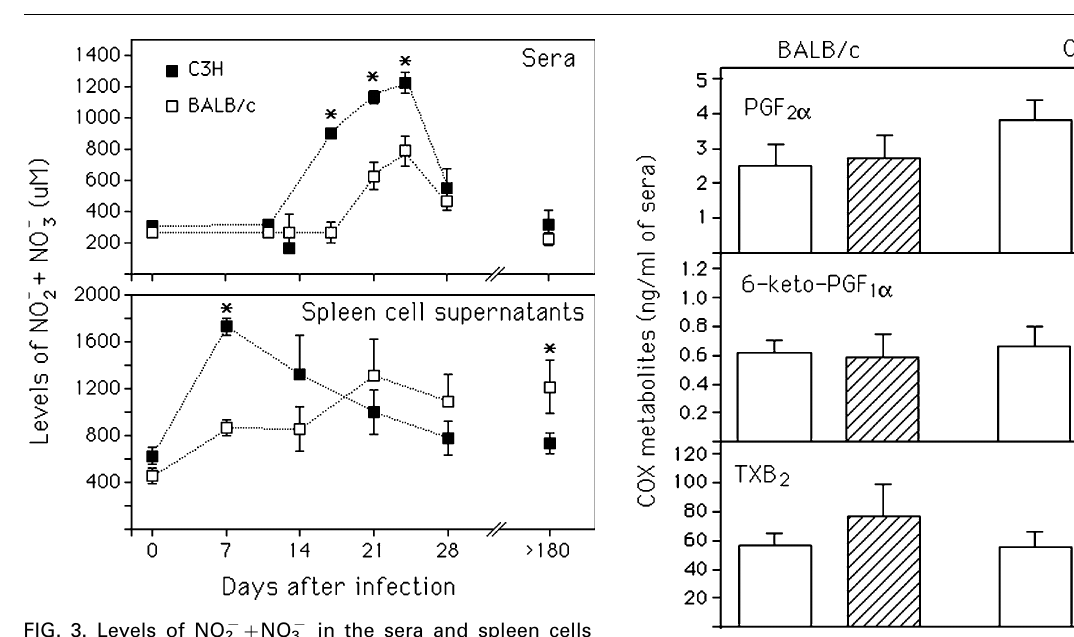
FIG. 3. Levels of NO 2 (cid:3) (cid:2) / NO 3 (cid:3) in the sera and spleen cells supernatants of acutely and chronically ( (cid:3) / 180 days p.i.) infected C3H and BALB/c mice. Means 9 / standard errors of 4 (cid:1) / 6 mice/group are shown. In the cell supernatants, the values increased over the non-infected control at 7 days p.i. in C3H mice and at 21 days p.i. in BALB/c mice (p B / 0.05, t-test). *Differences between mouse strains are significant (p B / 0.05, t-test).